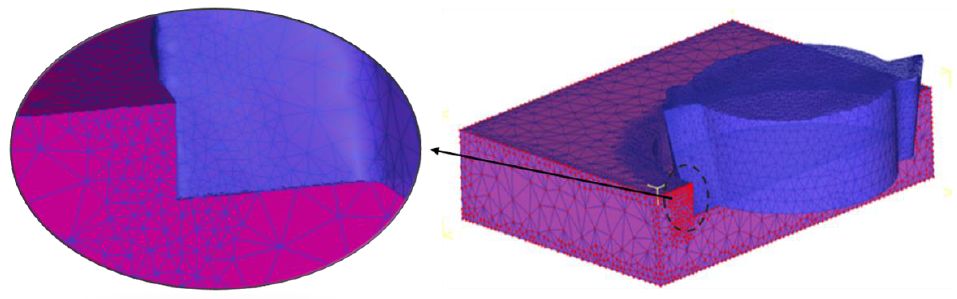
Figure 6. Boundary condition setting and partial enlarged detail.